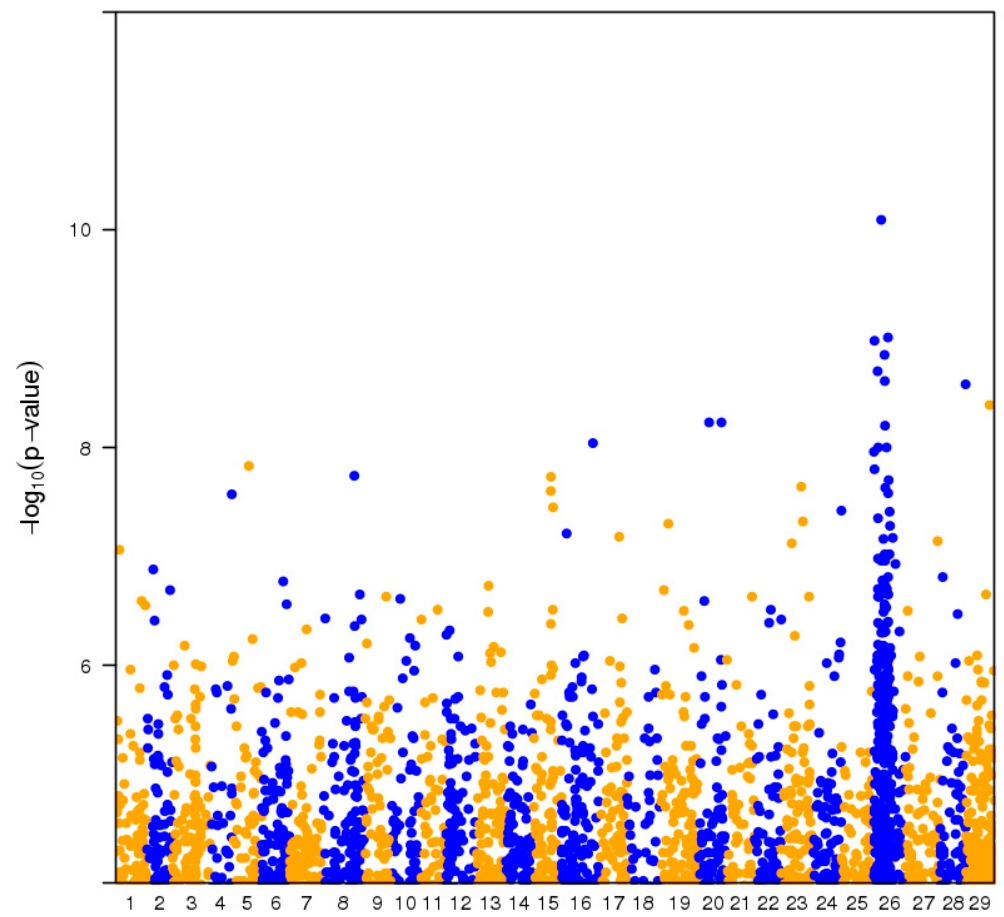
Figure 4. Pool-GWAS (genome-wide association study) scan for fruit AsA concentration level using Popoolation2. Symbols denote significance tests for association of individual SNPs with pool AsA level by Cochran–Mantel–Haenszel (CMH) Chi-Squared Test with normalised allele counts.